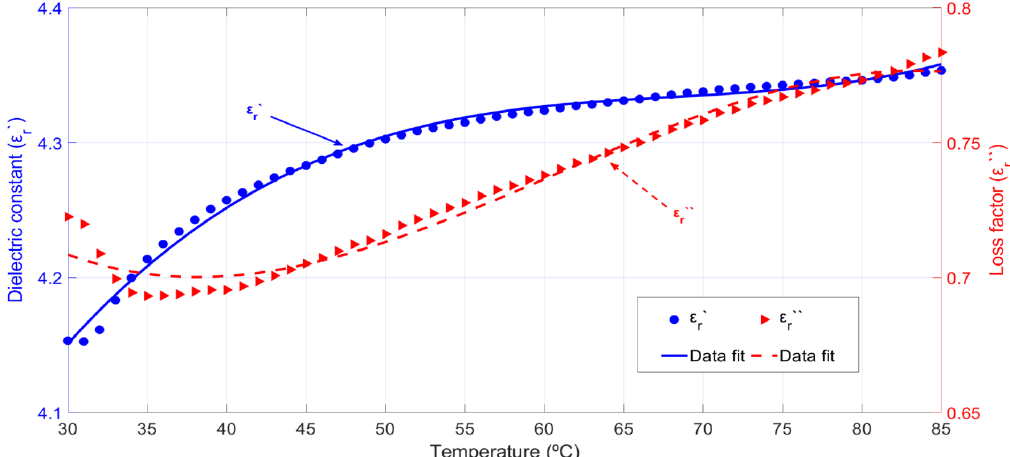
Figure 3. Cypress biomass permittivity behavior versus temperature and polynomial data fit for an average sample density equal to 0.34 g/cm 3 and an average dry-basis moisture content equal to 100%.